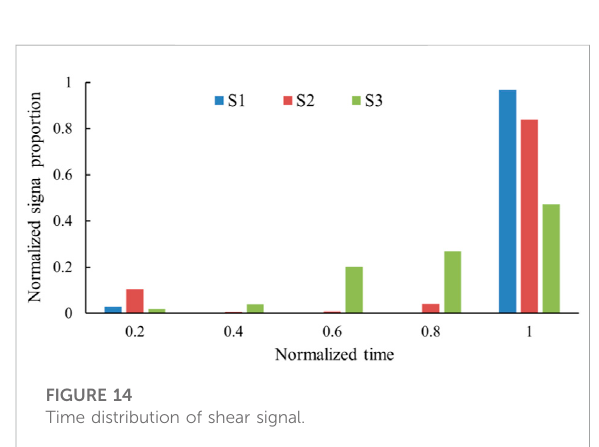
FIGURE 14 Time distribution of shear